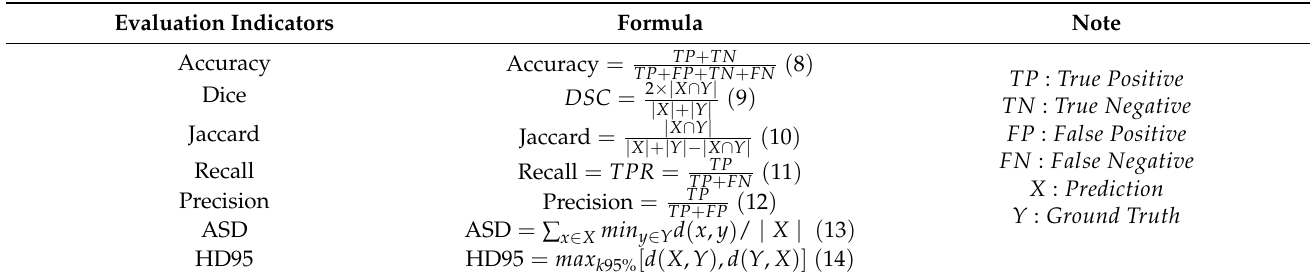
Table 2. Formulas for each evaluation metric.